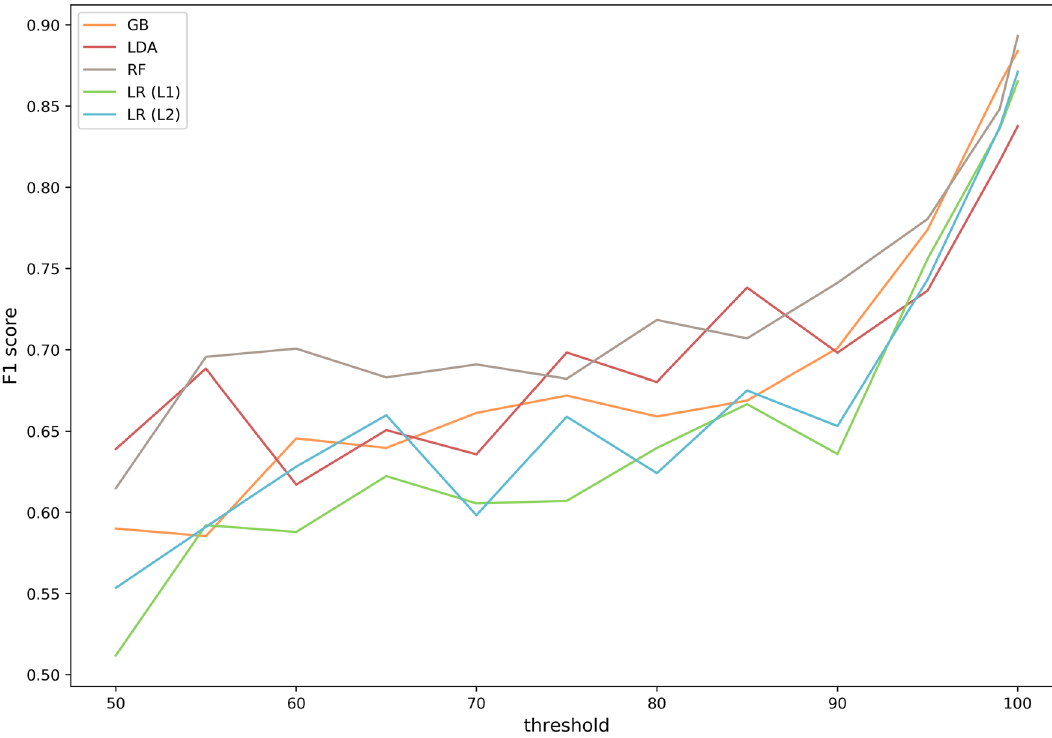
Figure 4. Cross-validated F1 scores of the tested predictive models across different thresholds for sequence similarity. Grouped, nested fourfold cross-validation was performed to tune the hyperparameters in the inner loop (GB, RF and LR) and measure performance in the outer loop. This was repeated for different thresholds of sequence similarity in the dataset that controlled the grouping in the cross-validation (i.e. the lower the threshold, the more sequences were grouped into the same fold making test set predictions more difficult). As performance metric, the F1 score was computed for every model at every